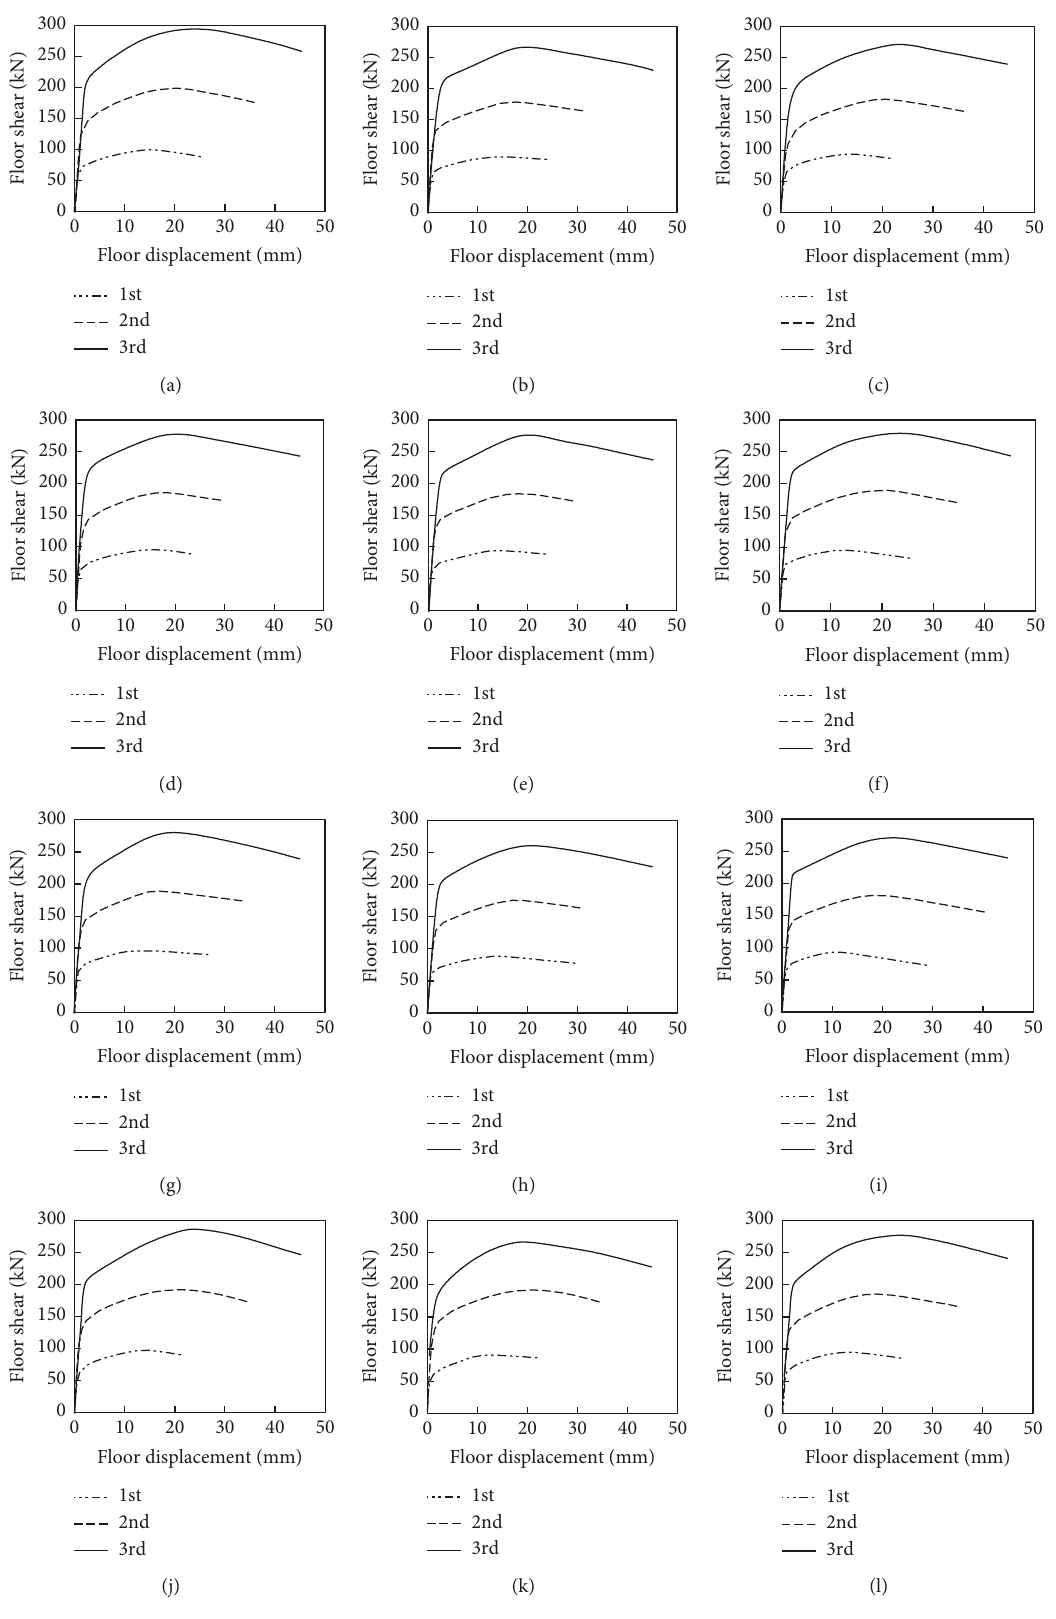
Figure 5: Horizontal floor force-lateral displacement curve Dem 2|1&4/B-C. (d) Dem 3|1&4/B-C. (e) Dem 1|2&3/B-C. (f) Dem 2|2&3/B-C. (g) Dem 3|2&3/B-C. (h) Dem 1|1&4/A-B. (i) Dem 2|1&4/A- B. (j) Dem 3|1&4/A-B. (k) Dem 1|2&3/A-B. (l) Dem